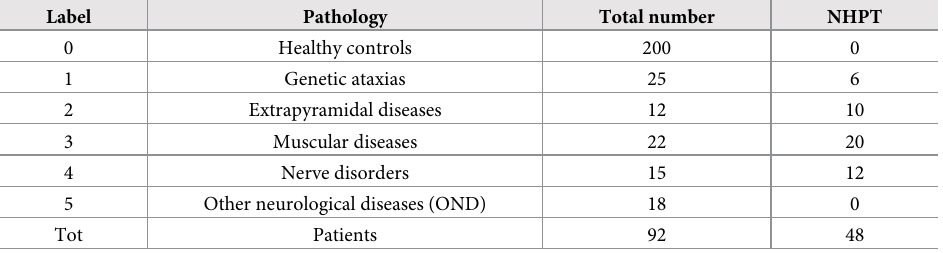
Table 1. Characteristics of the participants (healthy control and patients). The last column reports the number of subjects that have performed the Nine-Hole Peg Test as well as the SpAcCo test.